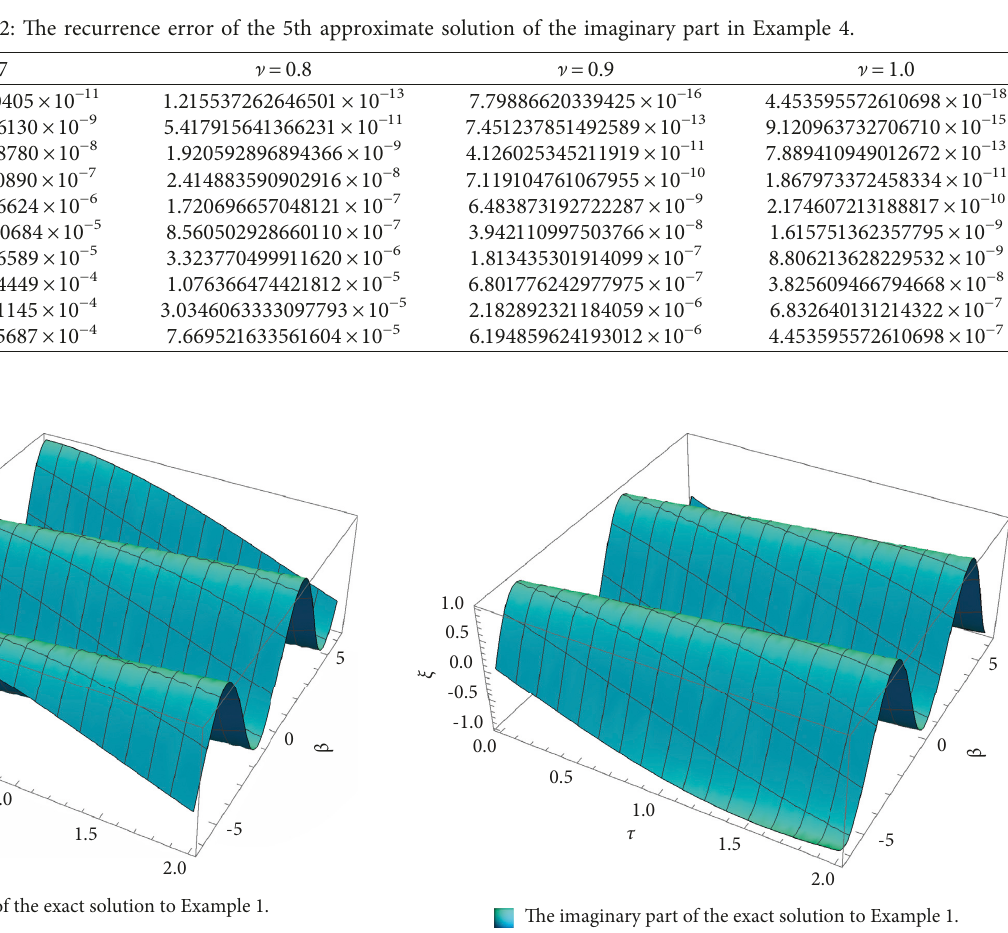
Figure 17: The real part of the exact solution to Example 1. Figure